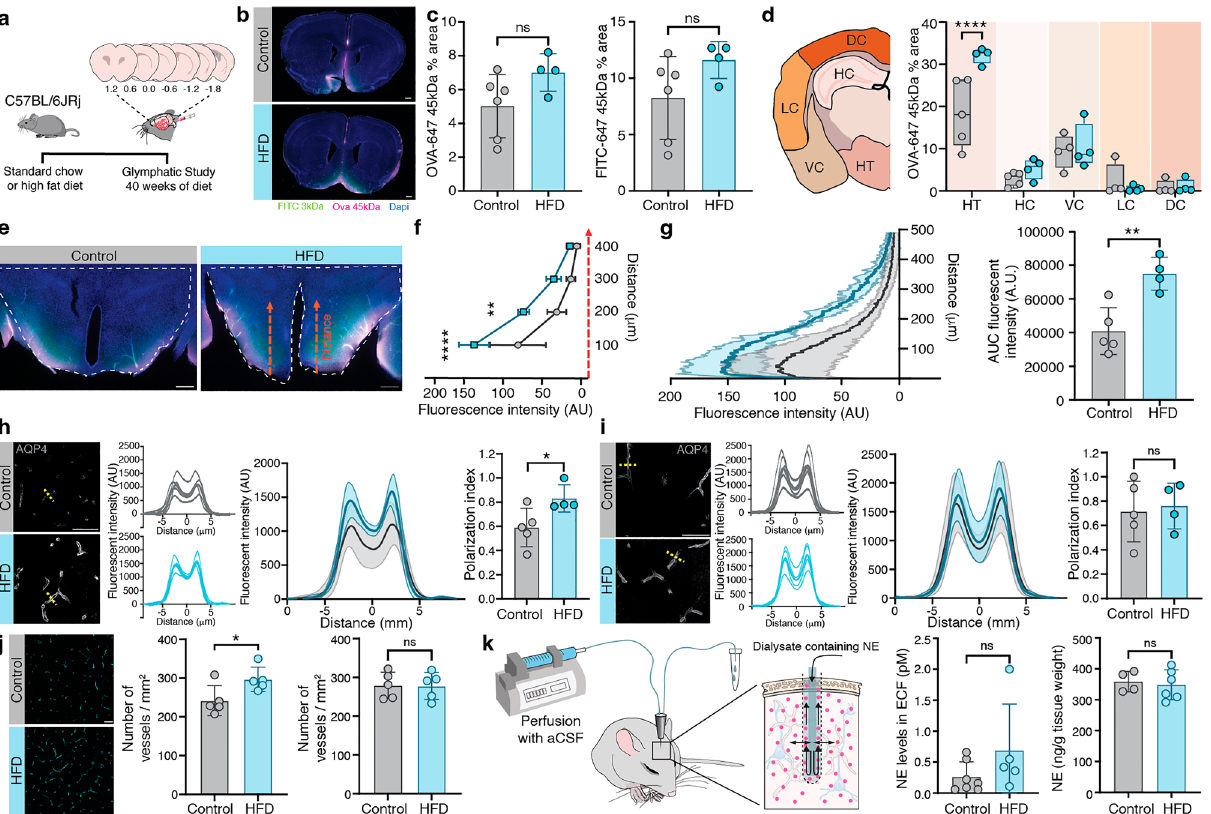
Figure 3. Increased glymphatic activity and AQP4 polarization in hypothalamus after 40 weeks of high-fat diet. ( a ) Intracisternal CSF tracer injection and brain sectioning. ( b ) Representative coronal brain sections (bregma 1.2 mm) with tracer signal. Scale bars: 200 µm. ( c ) Quantification of 45 kDa Ovalbumin-647 tracer (n = 4–5, ns = 0.0947) and 3 kDa FITC-tracer (n = 4–5, ns = 0.127) for 6 brain slices per animal shown as % total area. ( d ) Schematic of regional analysis for tracer fluorescent signal in hypothalamus region (HT), hippocampus (HC), ventral, lateral and dorsal cortex (VC, LC, DC respectively) at bregma -1.80 and corresponding regional quantification of the 45 kDa Ovalbumin-647 tracer (n = 4–5, 2-way ANOVA, **** < 0.0001). ( e ) Representative hypothalamus slice showing region of interest (bregma -1.80), red arrows = line ROIs used for tracer penetration analysis, assigned as a distance. Line ROIs positioned perpendicular to the brain surface. ( f ) Quantification of tracer intensity in the hypothalamus (AU = arbitary units). Increased tracer signal in HFD mice at 100 and 200 µm (2-way ANOVA, **** < 0.0001, ** = 0.0024). (n = 4–5 mice). ( g ) Left; Representative hypothalamic fluorescent signal of ovalbumin (45 kDa). Right; total fluorescent tracer signal shown as area under the curve (n = 4–5, ** = 0.0044), AU = arbitary units. ( h , i ) Representative AQP4 staining with line ROIs drawn across blood vessels (yellow dotted lines) in ( h ) hypothalamus and ( i ) hippocampus. Scale bars: 50 µm. Line ROI traces were plotted for each animal. Lines represent average fluorescent trace of 12–36 blood vessels per mouse (n = 4–5). Summarized traces are shown as group averages ± SD. Right: Polarization index of AQP4 in the ( h ) hypothalamus (* = 0.0388) and ( i ) hippocampus (ns = 0.7677) (n = 4–5). ( j ) Representative AQP4 staining in hypothalamus for quantification of vessel density in (left) hypothalamus (* = 0.0399) and (right) hippocampus (ns = 0.9457) (n = 5). ( k ) Illustration of microdialysis sampling of extracellular fluid (ECF) in hippocampus and quantification of norepinephrine (NE) levels in extracellular fluid (left) and hippocampus homogenates (right) (n = 5–7; ECF: ns = 0.1810, homogenates: ns = 0.7183). Graphs show mean ± SD. Unpaired t-tests if not otherwise indicated. Graphs created with GraphPad software (version 9.0, https:// www. graph pad. com/ scien tific- softw are/ prism/). Analysis of line ROI traces analyzed with ImageJ software (version 2.1.0/1.53c, https:// imagej. nih. gov/ ij/ downl oad. html). Schematics created in Adobe Illustrator 2022 (version 26.3.1, https:// www. adobe. com/ produ cts/ illus trator/ free- trial- downl oad. html) by Dan